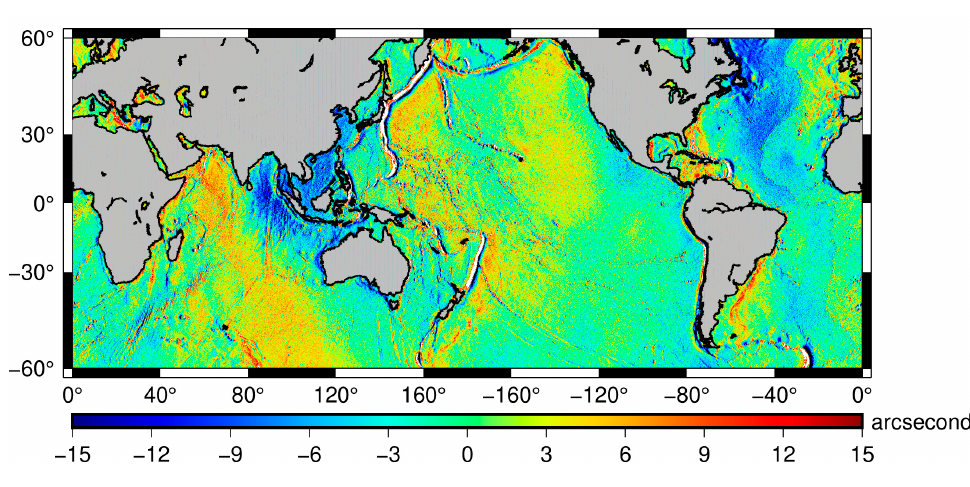
Figure 5. DOV_E2021.